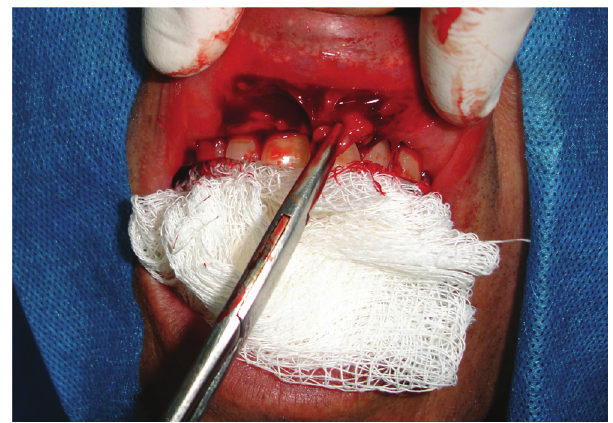
Figure 2 - Surgical correction of “acessory” lip